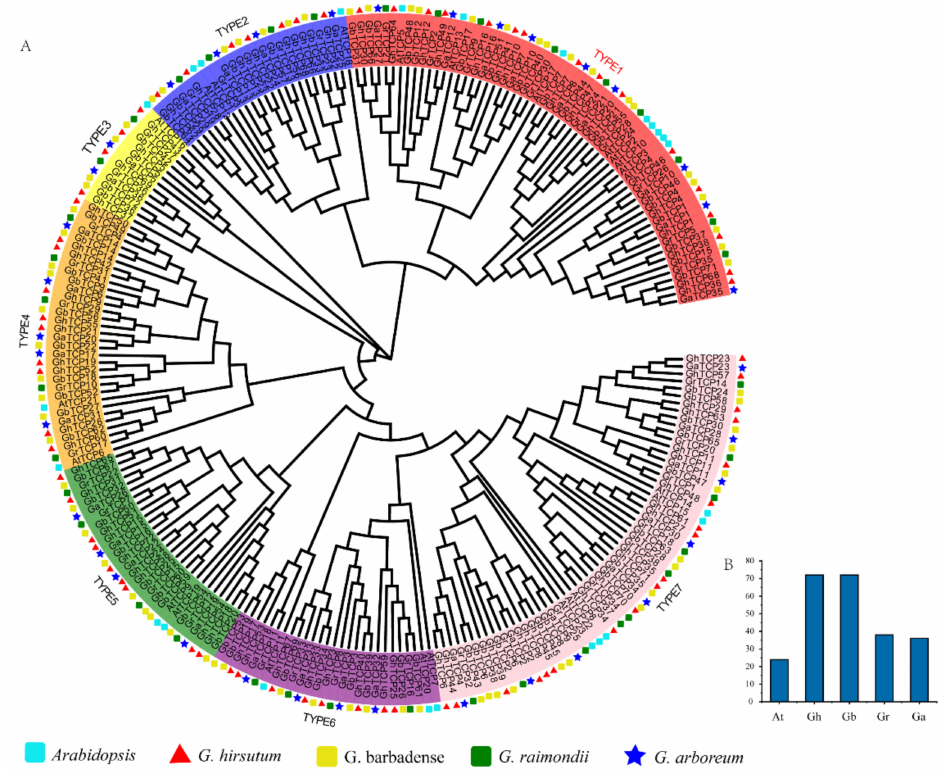
Figure 1. Phylogenetic analysis of TCP gene family members from Arabidopsis, G. hirsutum, G. barbadense, G. raimondii , and G. arboreum . ( A ) An unrooted phylogenetic tree was constructed using MEGA 6.0 and the Neighbor-Joining method, while the bootstrap test was performed with 1000 iterations. The seven subclades are indicated using different colors; TYPE1 belongs to the CIN protein, TYPE2 belongs to the TB1 protein, and TYPE3–7 belongs to the PCF protein. ( B ) Statistics of the number of TCP family genes in different